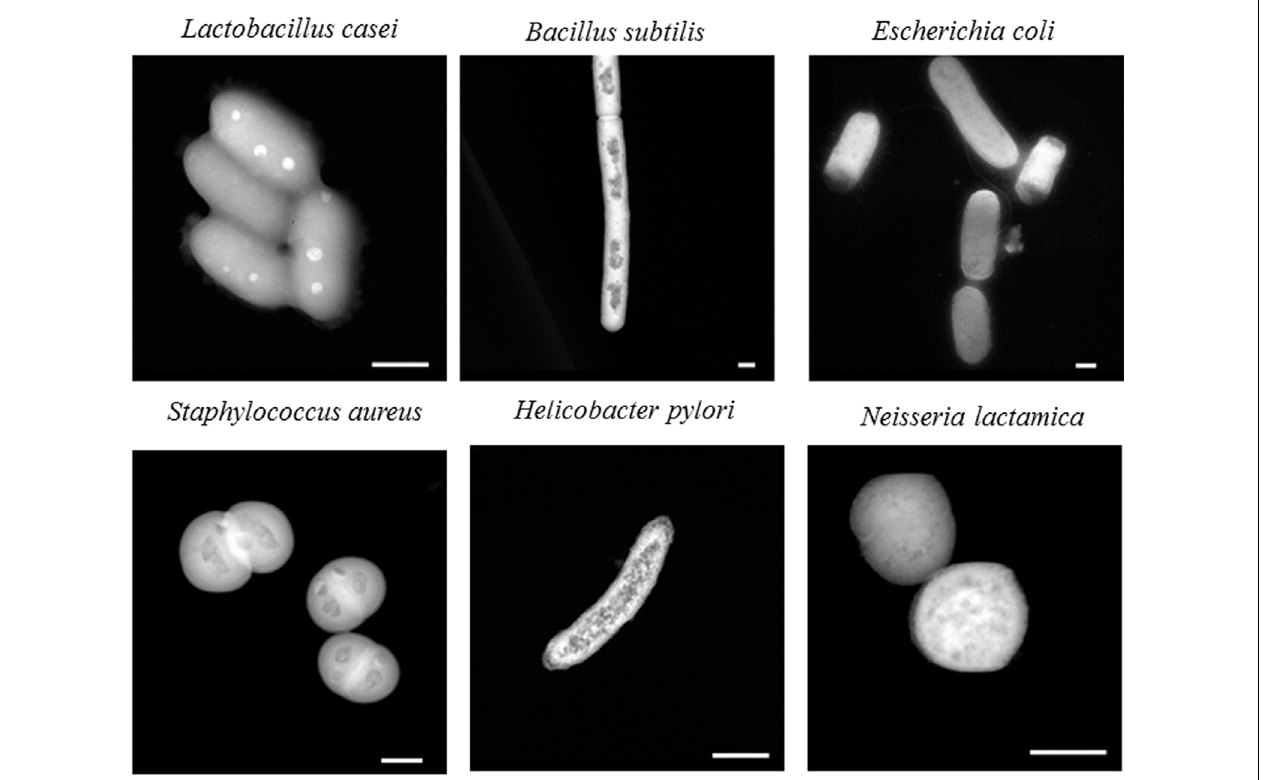
FIGURE 3 | STEM imaging of a variety of bacterial strains. Bacteria were fixed; whole-cell mounted, and imaged using an FEITitan 80-200 STEM. Selected images are representative samples from one biological replicate, with multiple bacteria imaged within each replicate. Scale bars (lower right) represent